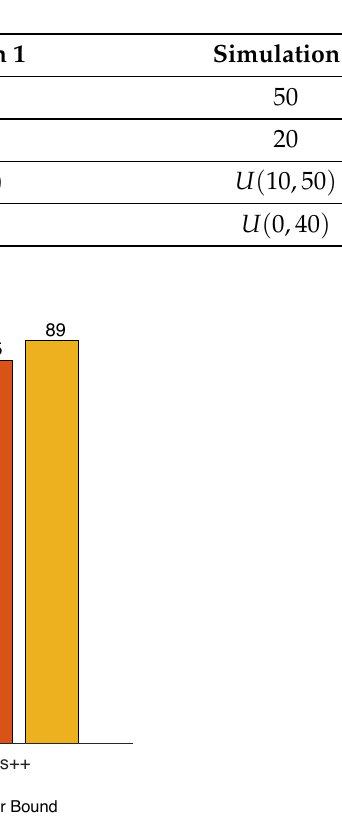
Figure 6. K-means++ accuracy for Simulation 1 parameters on unprocessed (UP) and preprocessed (P)